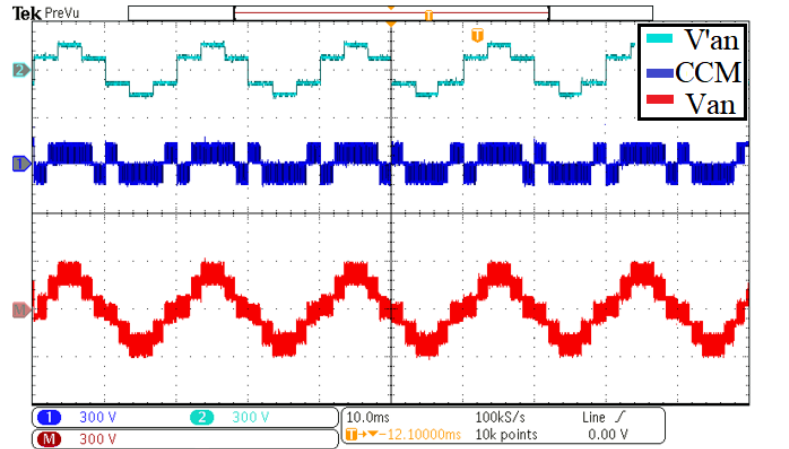
Figure 19. Experimental waveform of single-leg phase-voltage of AHMMC (V an ) tracing channels 1, 2, 3 (300 V/div).